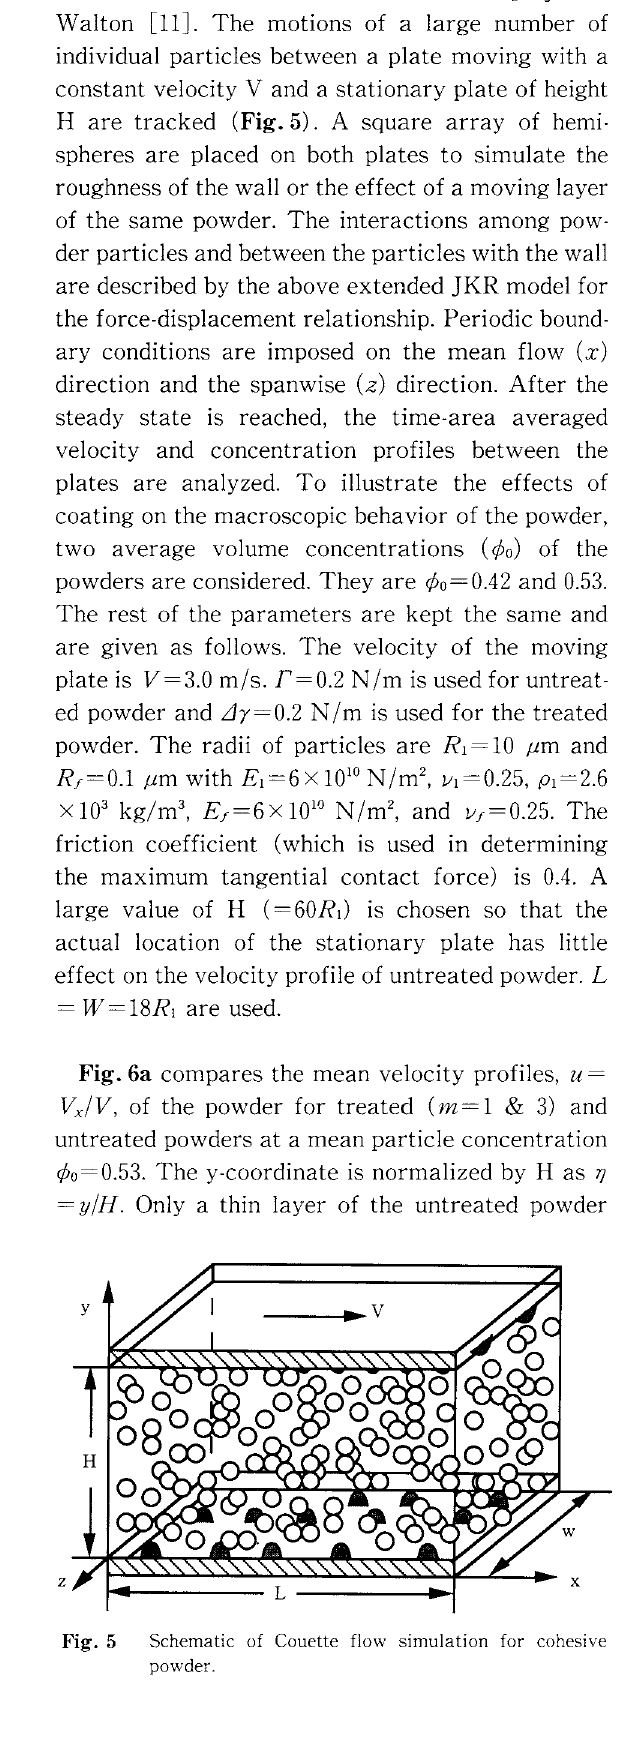
z Fig. 5 Schematic of Couette flow simulation for cohesive